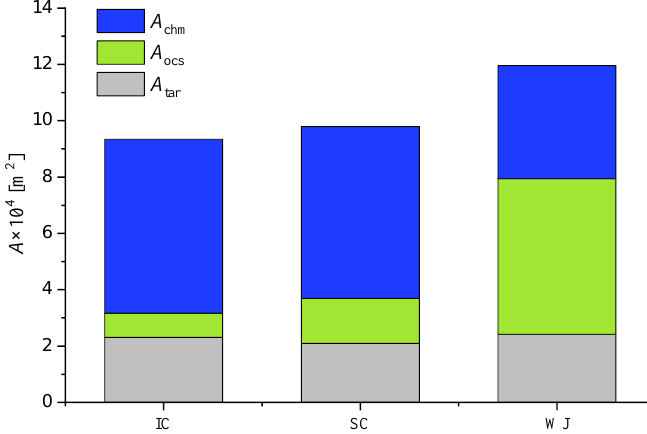
Figure 11. Internal cooling area comparison among different internal cooling structures.